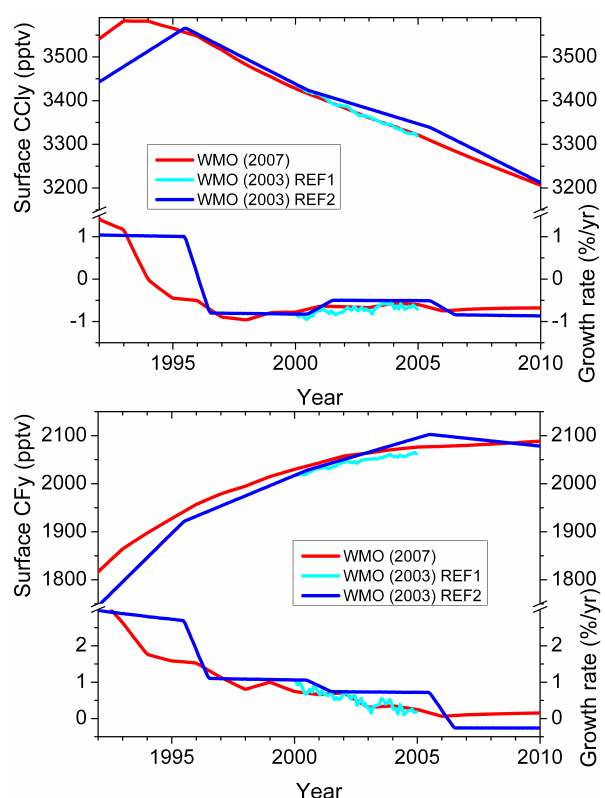
Fig. 1. Time series of monthly mean CCl y (top) and CF y (bot- tom) surface volume mixing ratios (in pptv) and growth rates (in % per year) from different halocarbon scenarios between 1992 and 2010. The one called “WMO (2003) REF2” corresponds to the sce- nario Ab in WMO (2003) and was used by KASIMA and the 2-D model. The “WMO (2003) REF1” time series of CCl y and CF y are based on that same scenario until the year 2000, but were corrected by additional measurements between 2000 and 2004. It was used by SOCOL. The “WMO (2007)” scenario is the one called A1 in WMO (2007) and was used by SLIMCAT and EMAC in this